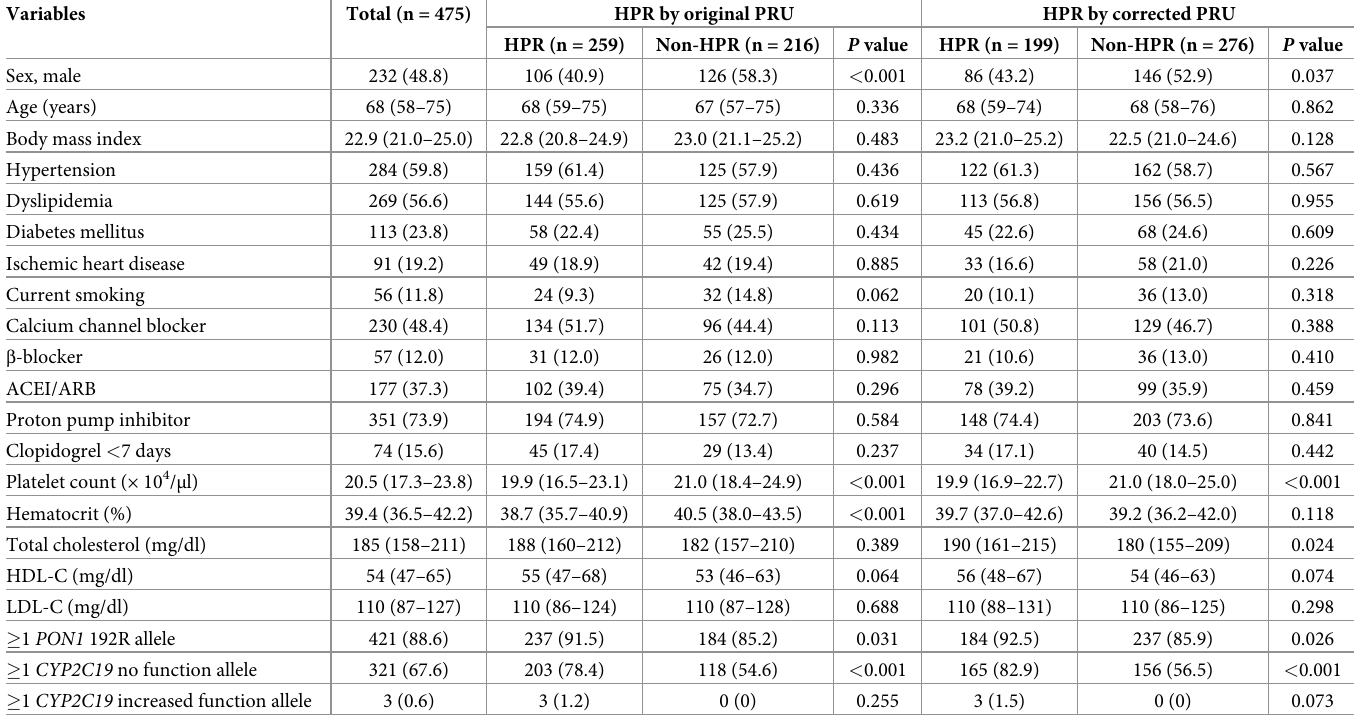
Table 2. Univariate analysis of high platelet reactivity in patients undergoing elective